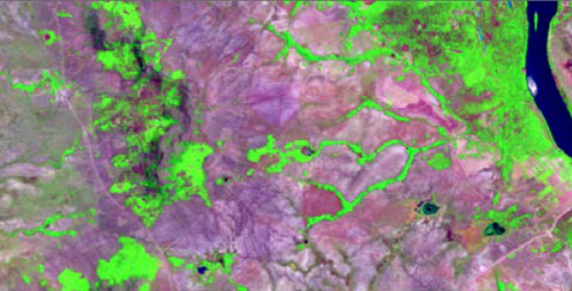
Figure 3 – Example of an area constituted by natural non-forest vegetation in the municipality of Boa Vista, Roraima state. Areas in magenta are herbaceous vegetation, green tones are shrubby and arboreal vegetation, and blue are water bodies.